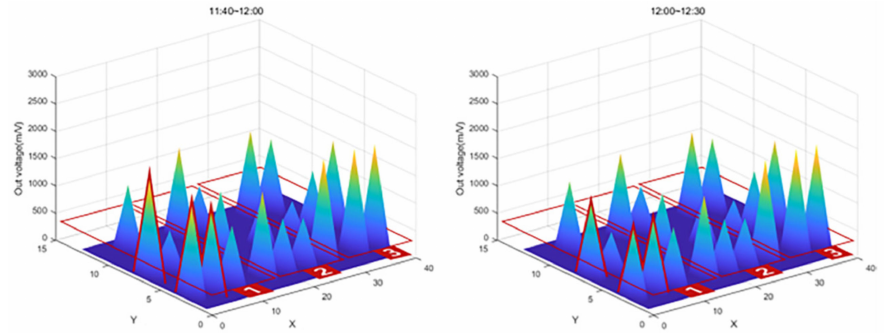
Figure 28. Sum of 3D graph values for data from 11:40–13:30.